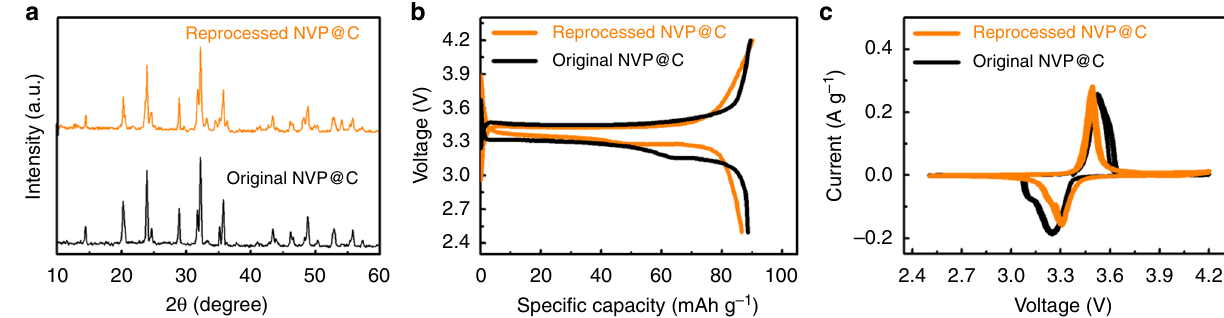
Fig. 4 Characterizations of the reprocessed NVP@C compared with the original NVP@C. a XRD spectra. b Charge/discharge curves at 5 C. c